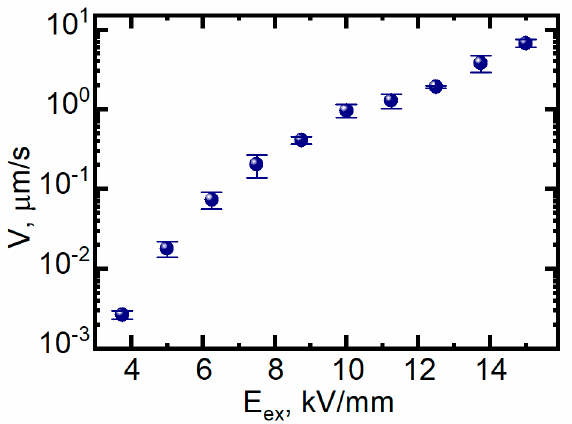
Figure 5. Field dependence of the slow Y − wall motion velocity of the isolated domain.